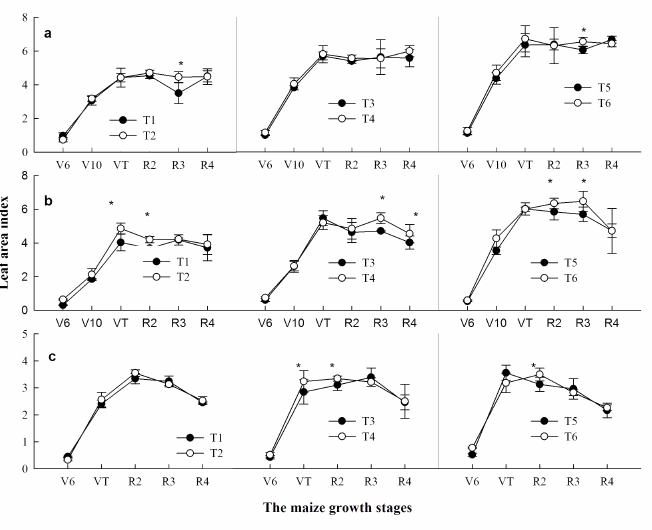
Figure 7. Change in LAI from V6 to R4 (maize growing stage) under integrated effect of organic manure and planting densities.In this figure, letter ( a ) means the year 2011, ( b ) means the year 2012 and ( c ) means the year 2013, ∗ means significant difference at p < 0.05.